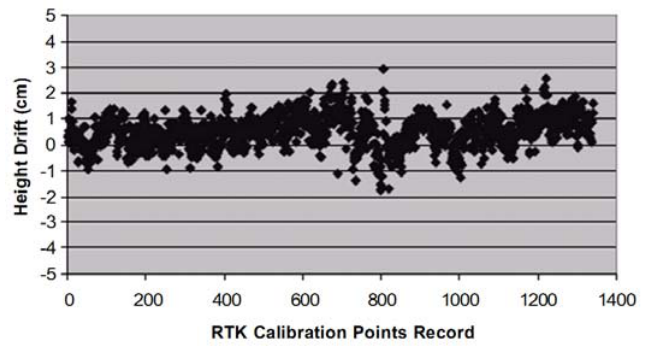
Figure 5. Scatter plot of the RTK-GPS height z drift results from the field evaluation measurements.